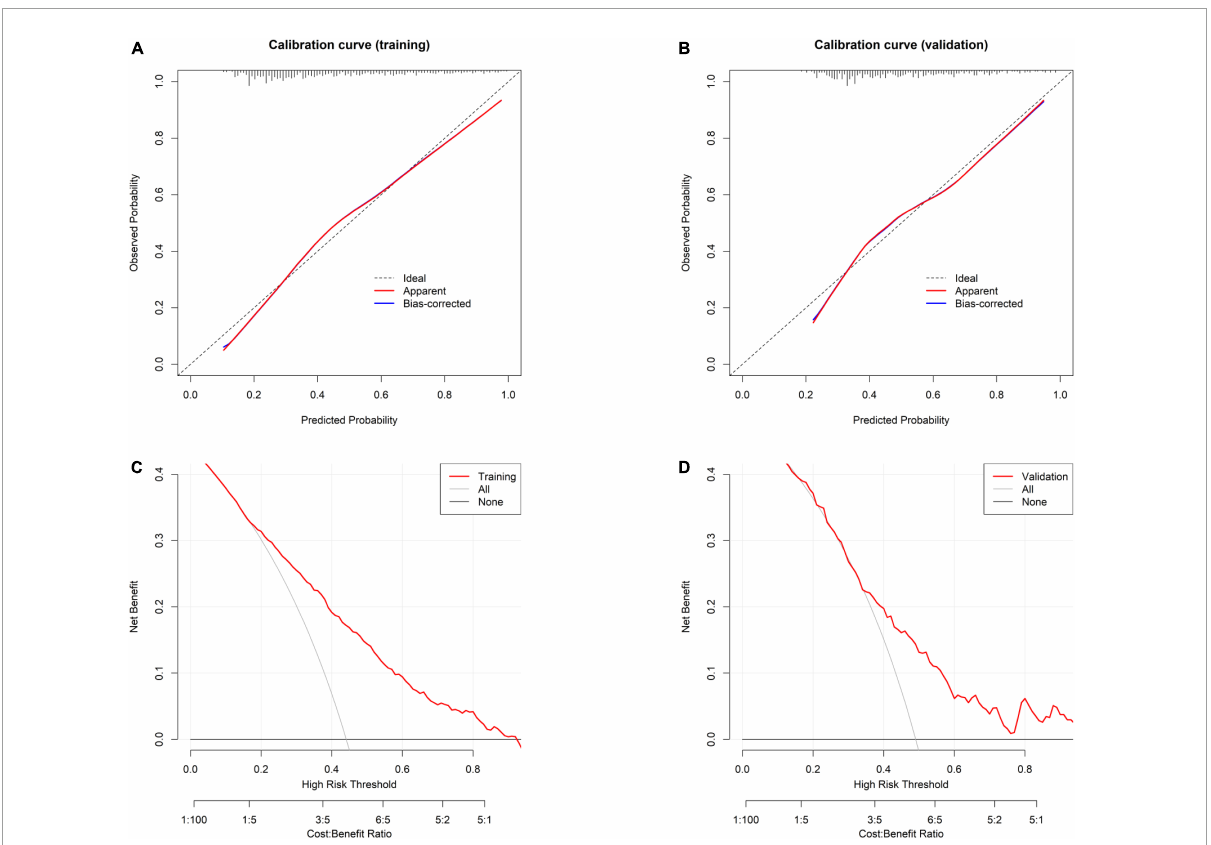
FIGURE4 Evaluation of model’s calibration and clinical usefulness. (A) Calibration curve for the model in the training group. (B) Calibration curve for the model in the validation group. Calibration curve is plotted with predicted probability against observed probability. A dotted diagonal line in the curve indicates perfect consistency between the predicted and observed probability. (C) Decision curve analysis for the model in the training group. (D) Decision curve analysis for the model in the validation group. Decision curve is plotted with different thresholds against net benefit. Larger space between the red line and the two reference (a treat-for-all line and a treat-for-none line) lines indicates better clinical